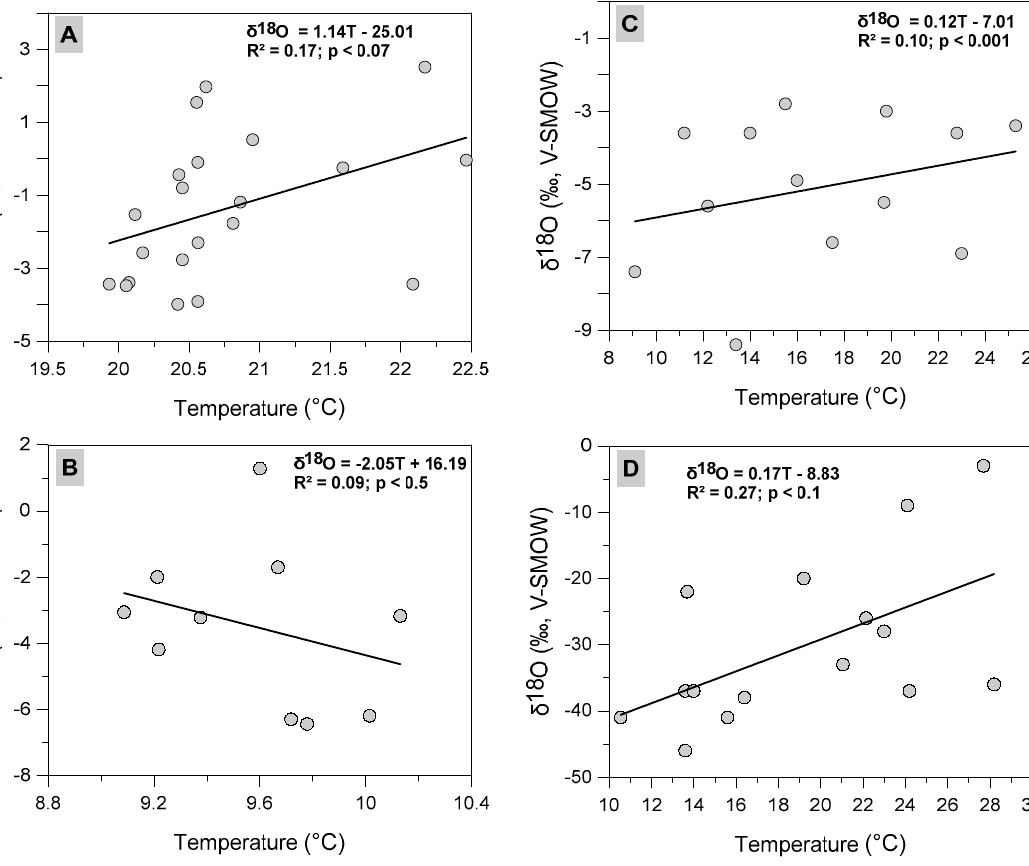
Figure 5. δ 18 O monthly values from isolated stations plotted against temperature in Virunga, located on the limit between Central and Eastern Africa, within the western branch of the East African Rift System ( A , B ), and the Central Mediterranean ( C , D ). In Virunga, the data used in A and B are respectively from the OVG (1535 m a.s.l.) and summit (3460 m a.s.l.) stations (see map of Figure 1A), while in the Central Mediterranean the data used in C are from a station in the Spagnuola area (see map of Figure 1B2) and data for D are from the LBR station in Stromboli (see map of Figure 1B1). No clear relationships can be recognized between isotope composition and temperature.